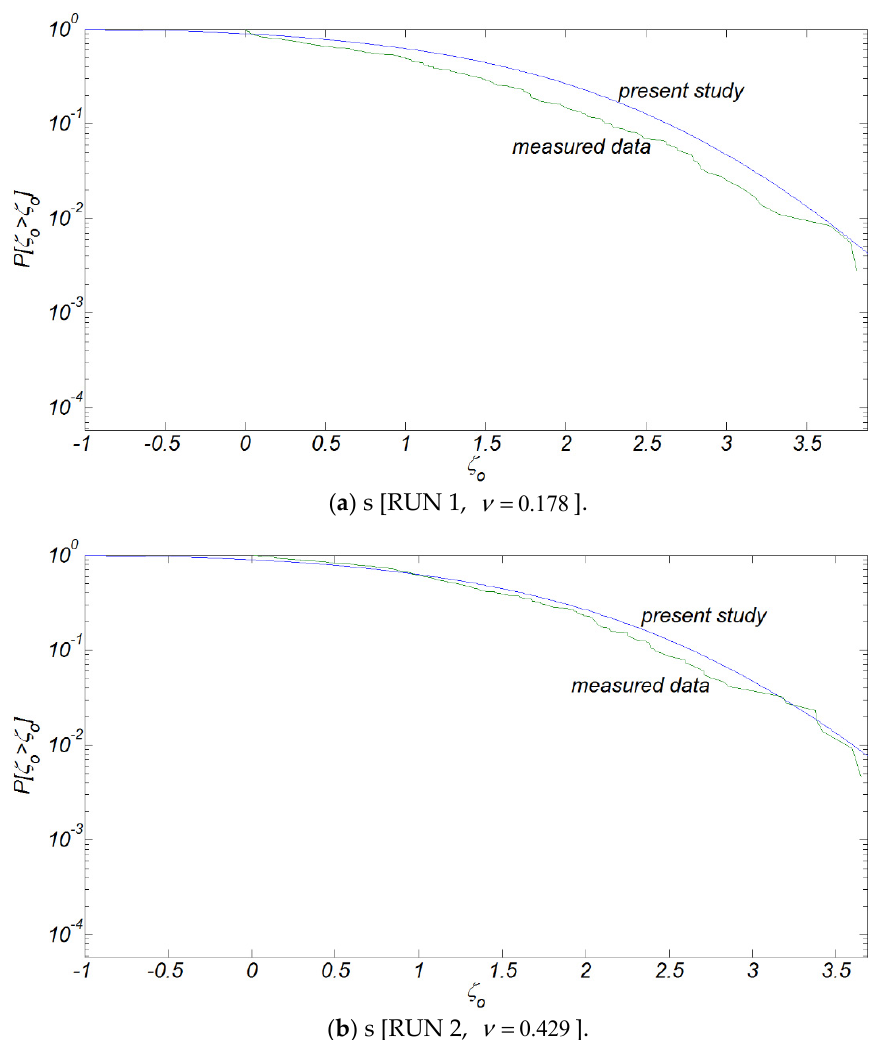
Figure 6. Evolution of exceedance probability [ ] o P nonlinearity.